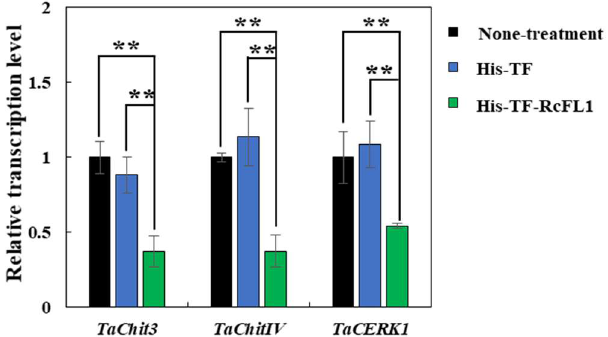
Figure 7. The RcFL1 protein treatment decreases the transcripts of wheat chitinases and receptor-like kinase in infiltrated leaves. RNAs were extracted from wheat leaves at 3 d post treatment with His-TF-RcFL1 or the His-TF (CK) in 25 µ L at a concentration of 5 µ M/L and none-treatment. The wheat Actin gene was used as an internal control to normalize the data. SE was calculated based on three technical replicates. ** indicates significant differences ( p < 0.01, t -test) between His-TF-RcFL1 and the His-TF infiltrated